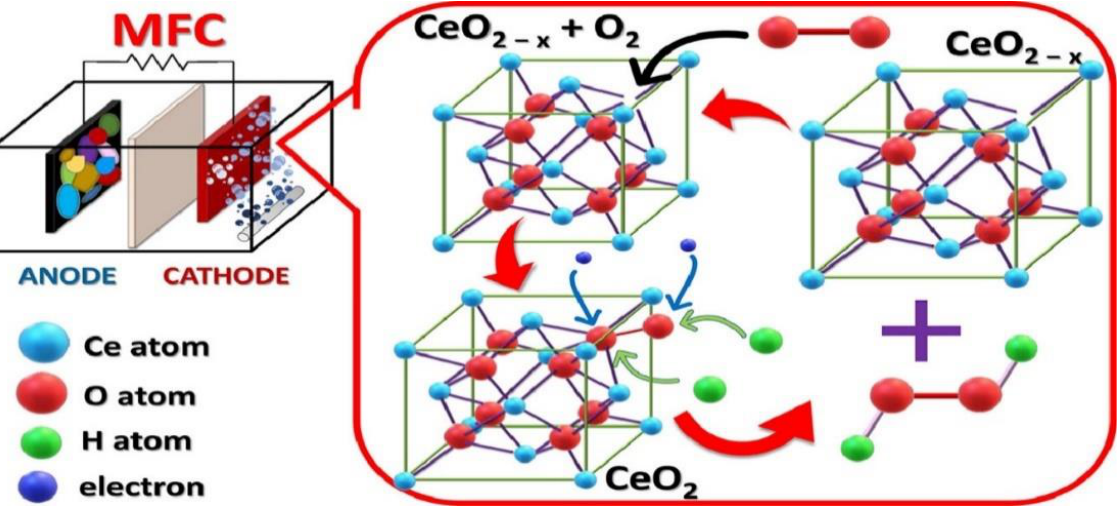
Figure 16. Schematic diagram of a microbial fuel cell. Reprinted with permission from [147]. Copy- right 2021 Elsevier.